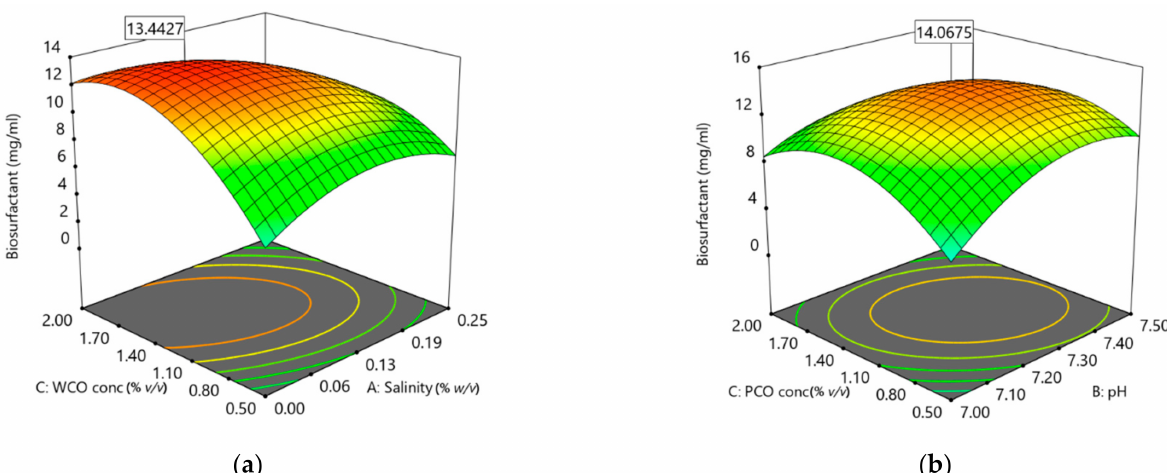
Figure 8. Three-dimensional (3D) response surface plots for the significant factors identified in CCD for biosurfactant production using WCO, ( a ): salinity and WCO concentration; and PCO ( b ): pH and PCO